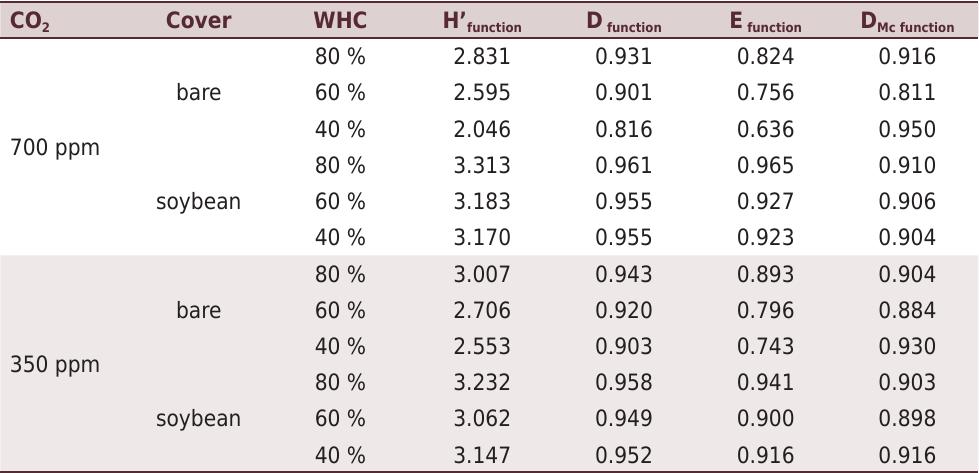
Shannon-Wiener (H’) and Simpson (D) indices were used to estimate the microbial diversity; Pielou (E) and McIntosh (DMc) indices were used to estimate the microbial diversity. WHC: water holding